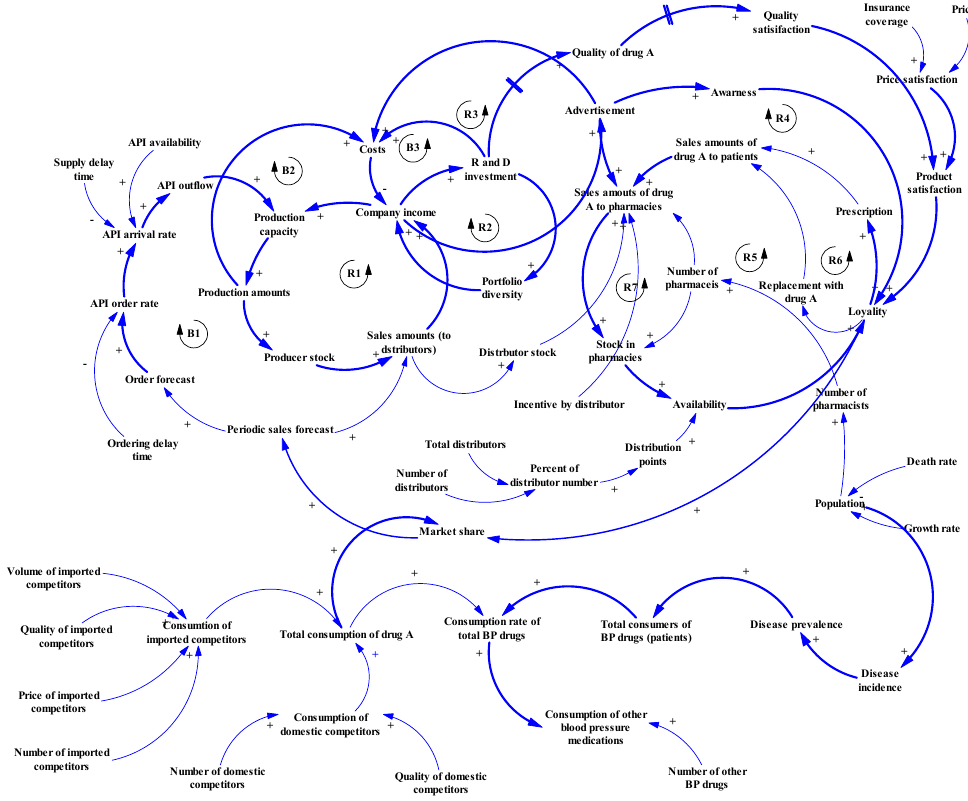
Figure 2. Qualitative system dynamic model of the pharmaceutical product life cycle .